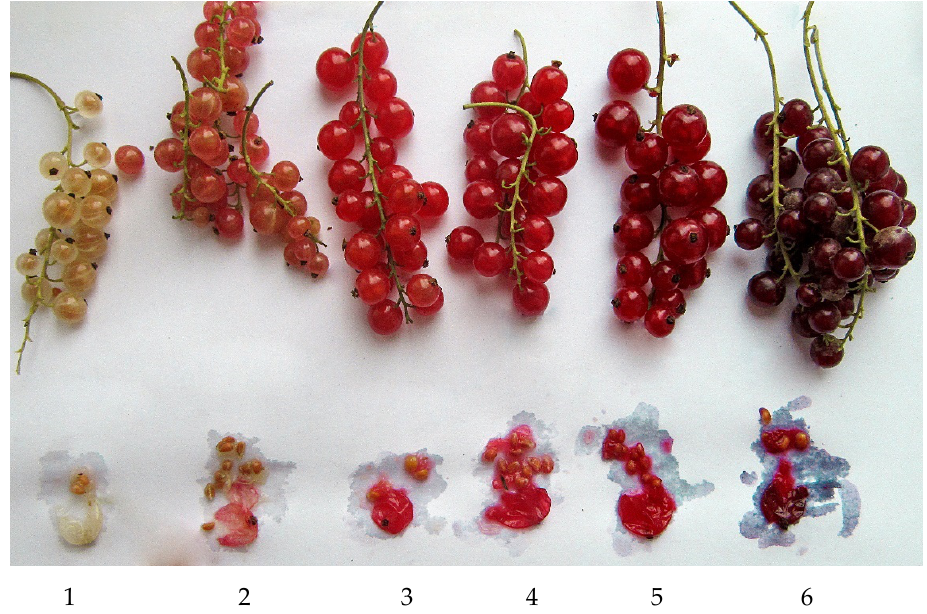
Figure 5. Variety of berry color of red currant cultivars (1—Weisse Hollandische, 2—Batishevskaya, 3—hybrid form (not included in the analysis), 4—Pamyat Gubenko, 5—Jonkheer van Tets,